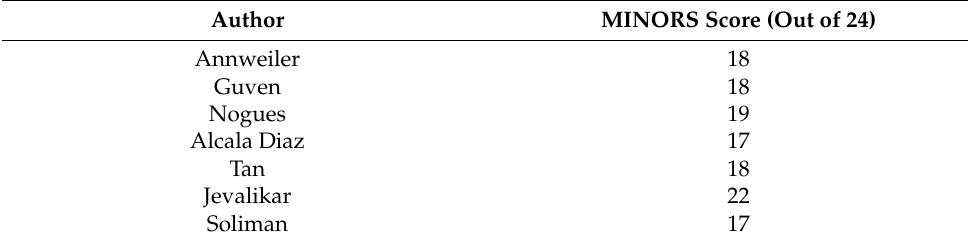
Table 3. MINORS Score for non-randomized